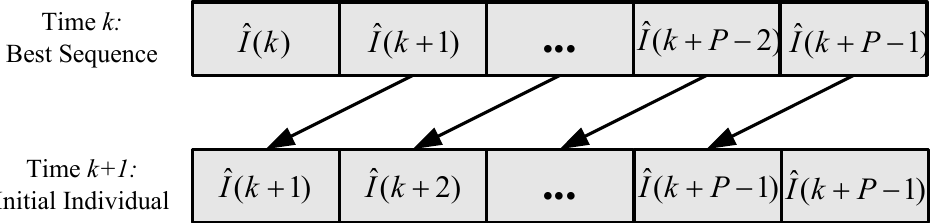
Figure 6. Initialization of one special individual by introducing the best control sequence optimized in previous step into the present